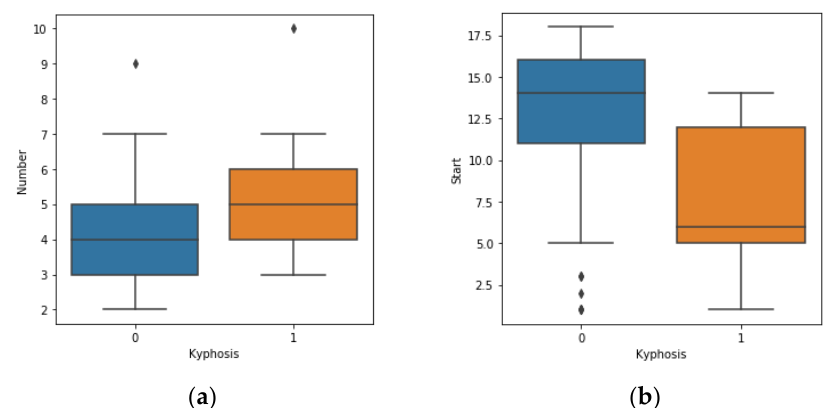
Figure 13. The boxplot of kyphosis against Age feature to detect outliers.